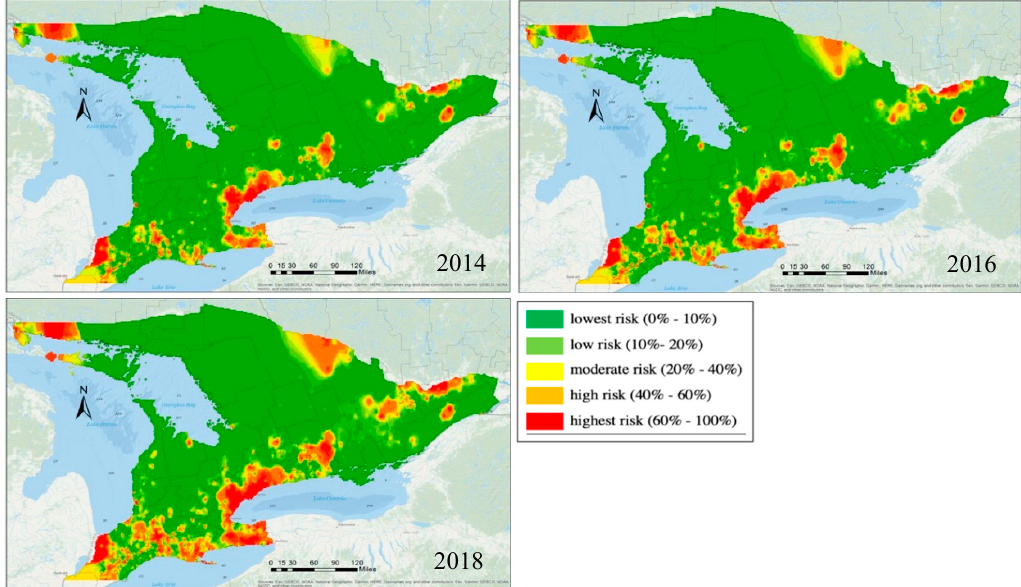
Figure 8. Risk maps predicted by the proposed model for 2014, 2016, and 2018.